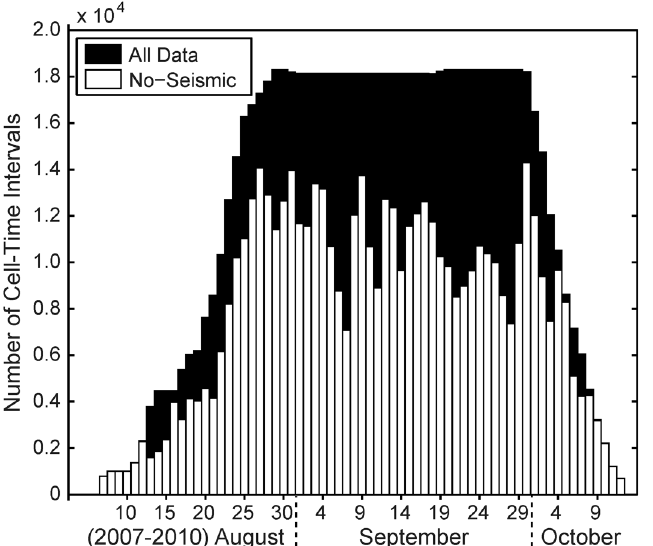
Fig 6. Frequency distribution of samples without detected airgun pulses, as a function of date. The black bars show the total number of cell-time intervals while the white bars show the number of cell-time intervals without any detected airgun pulses, as a function of date in all four years (2007 – 2010). The top, nearly flat part of the black bars corresponds to the dates during which all DASAR arrays were deployed in all years. The right edge of the plot is steeper than the left edge because the period of retrieval in October was less variable in timing than the period of deployment in August (see Table 1). The figure shows that cell-time intervals without detected seismic activity are not biased toward certain phases of the migration, and thus any differences between calling rates found between no seismic and seismic cell-time intervals are not contaminated by seasonal